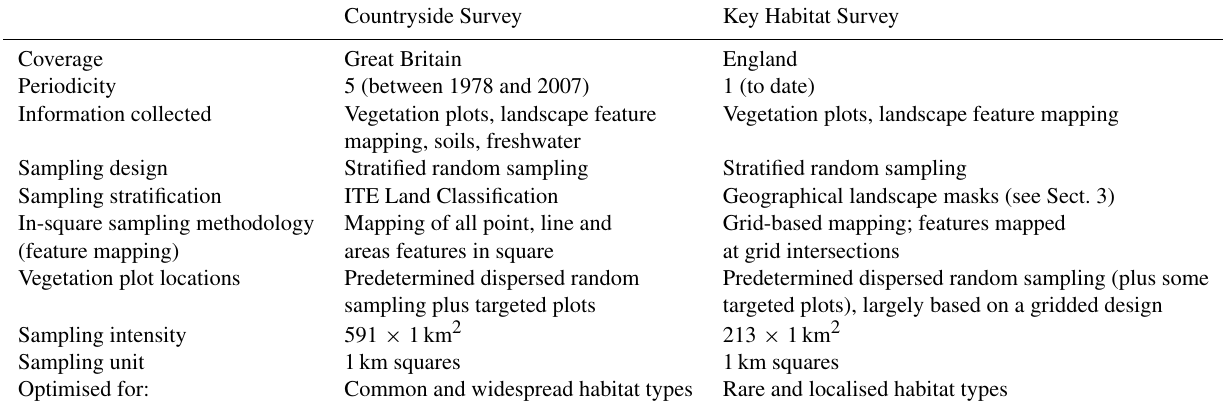
Table 1. Table showing a comparison between the Countryside Survey and the Key Habitat Survey. Countryside Survey Key Habitat